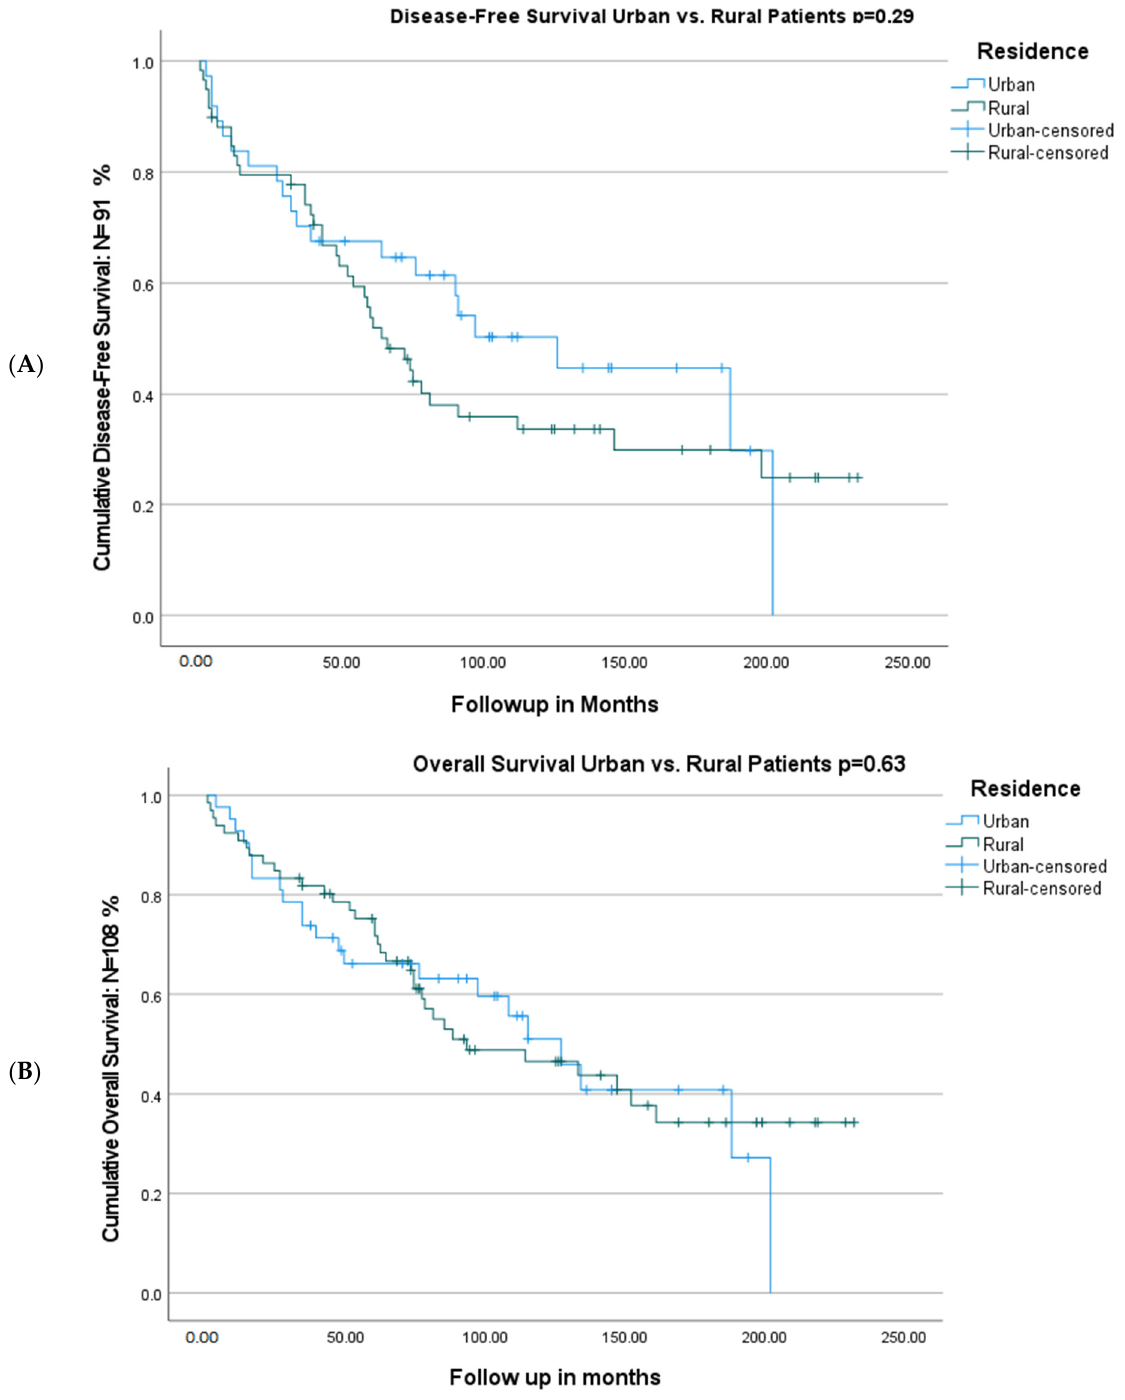
Figure 4. Comparison of rural versus urban patient outcomes. ( A ) Kaplan–Meier disease-free survival curves of 91 patients with early-stage invasive breast cancer showed no difference between urban and rural patient populations ( p = 0.29). ( B ) Kaplan–Meier overall survival curves of 108 patients with breast cancer showed no difference between urban and rural patient populations ( p = 0.63).